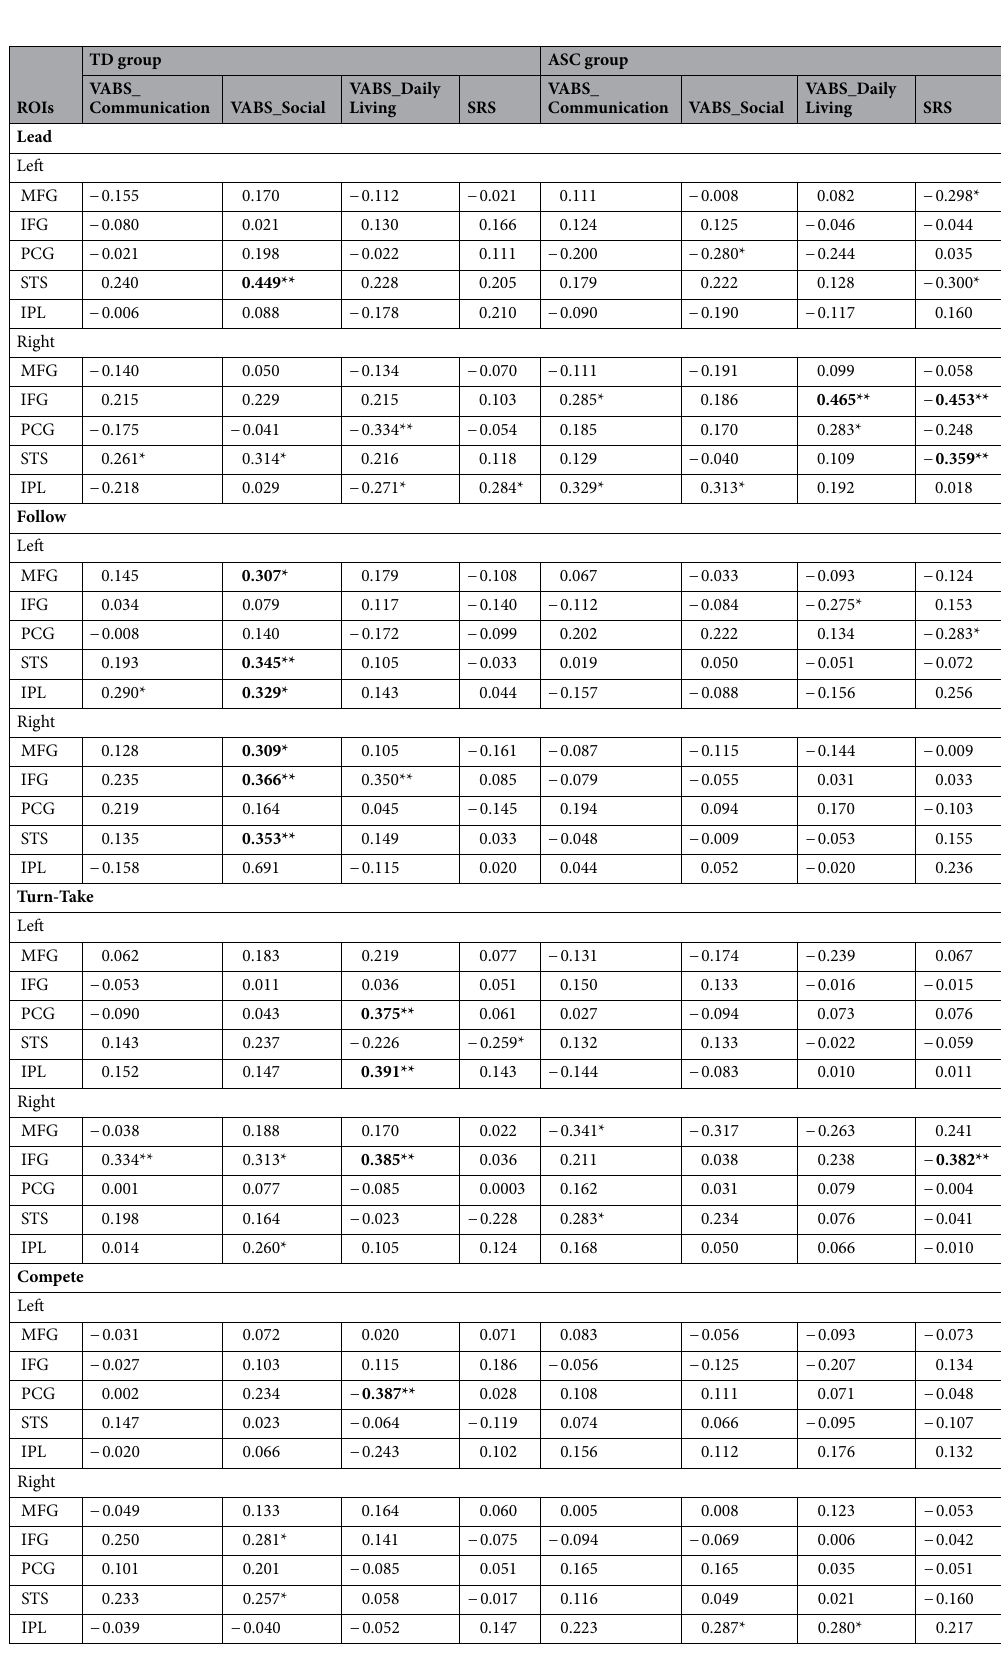
Table 1. Correlations between cortical activation and the VABS and SRS scores in children with and without an ASC. * p < 0.05; ** p < 0.01. Bolded font indicates p -values survived for FDR